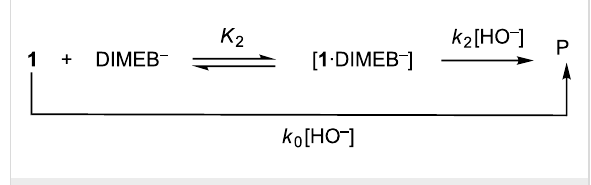
Scheme 2: Mechanism of the hydrolysis reaction of 1 mediated by